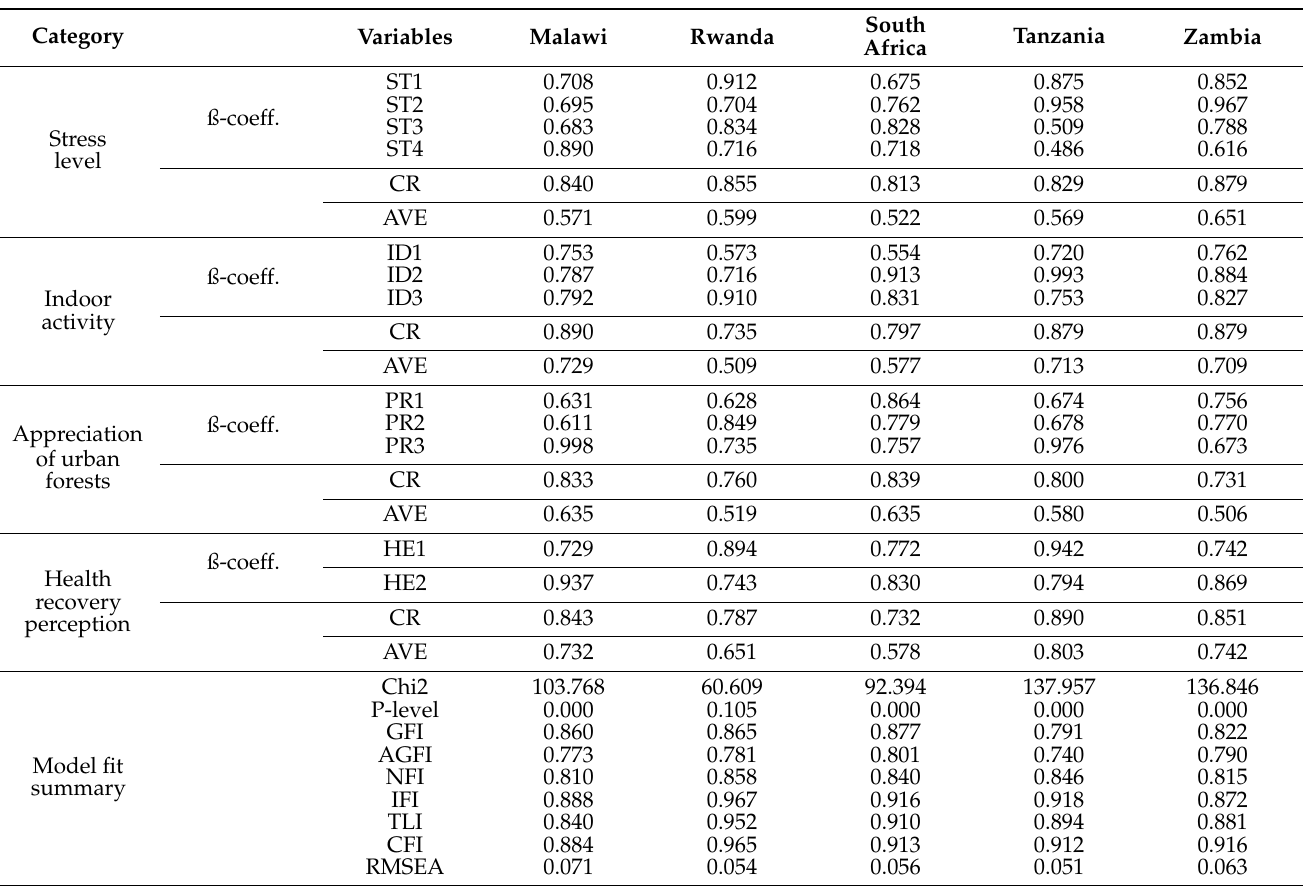
Table 6. Confirmatory factor analysis